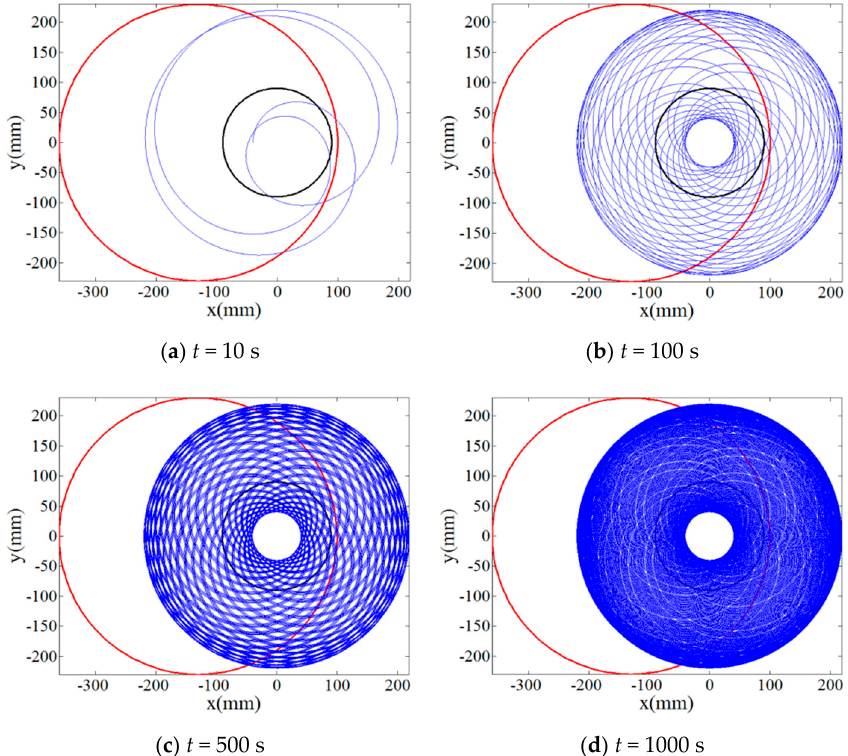
Figure 5. Relationship between trajectory of the single abrasive particle on target surface at i pw = 0.4634… and lapping time ( a ) t = 10 s; ( b ) t = 100 s; ( c ) t = 500 s; ( d ) t = 1000 s.